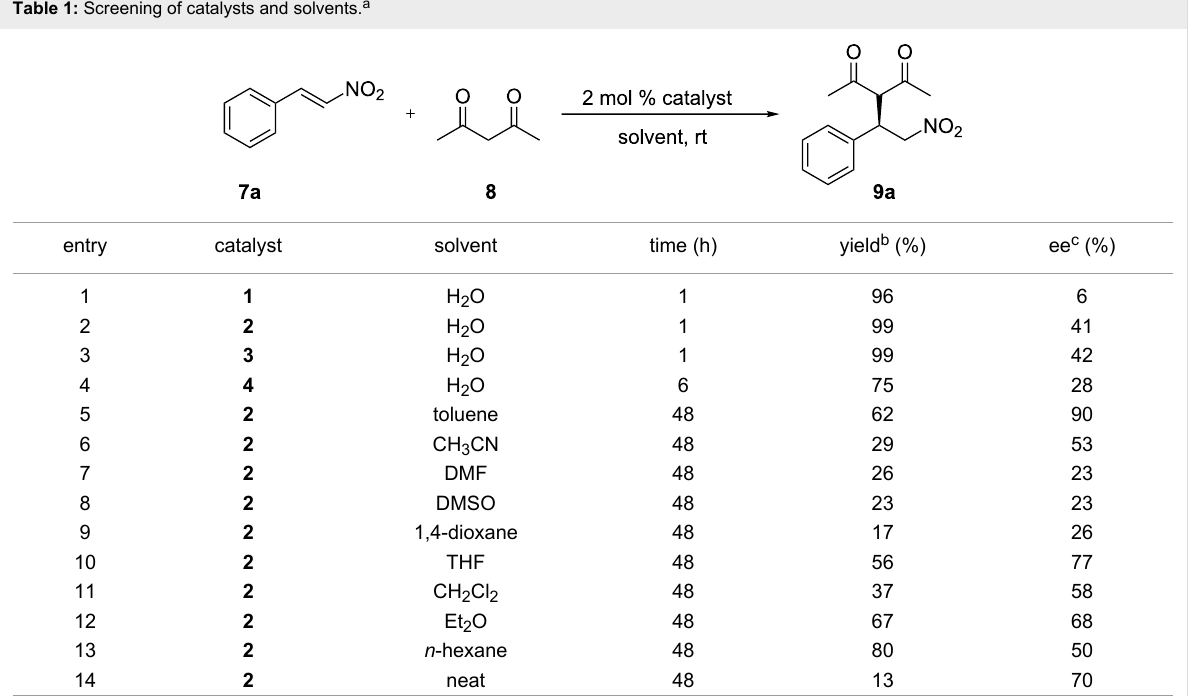
Table 1: Screening of catalysts and solvents.